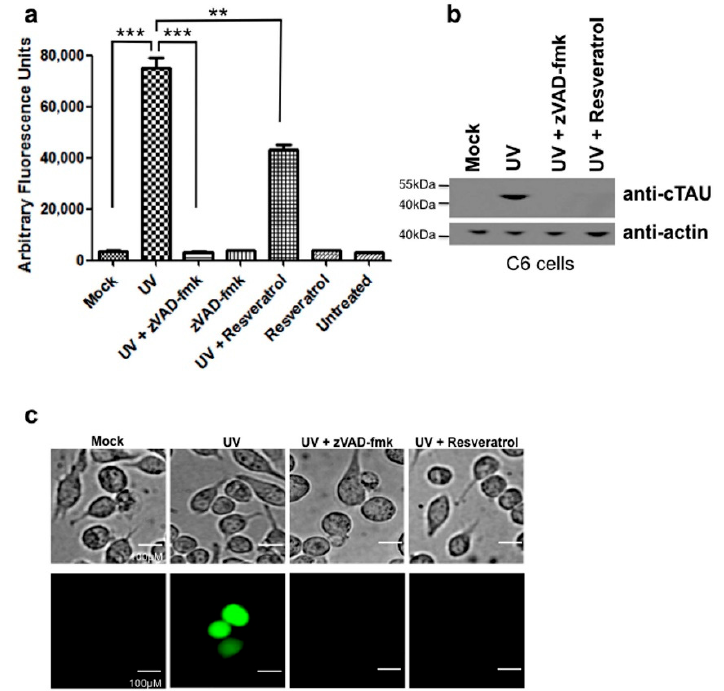
Figure 2. Resveratrol inhibits tau cleavage induced by UV-irradiation in C6 cells. ( a ) C6 cells were UV-irradiated and caspase activity measured using the caspase substrate Ac-DEVD-AFC. Values were plotted as arbitrary fluorescence units. C6 cells that were UV-irradiated showed a significant increase in caspase activity compared to mock treated (***, p < 0.0001). C6 cells UV-irradiated and pretreated with resveratrol showed a slight, but significant decrease in caspase activity compared to UV-irradiated cells alone (**, p = 0.0015). C6 cells treated with the pan-caspase inhibitor zVAD-FMK showed a significant decrease in caspase activity (***, p < 0.0001); ( b ) C6 cells that were UV-irradiated were immunoblotted for cleaved tau. C6 cells that were UV-irradiated showed detectable cleaved tau while cells pretreated with zVAD-fmk or resveratrol showed no detectable cleaved tau; ( c ) Resveratrol prevented NFT formation induced by UV-irradiation in C6 cells. C6 cells that were pretreated with resveratrol were UV-irradiated and then stained with Thioflavin S to detect NFT formation. Scale bar, 100 µ m. All experiments were performed in triplicate and values were expressed as mean +/ − SEM.